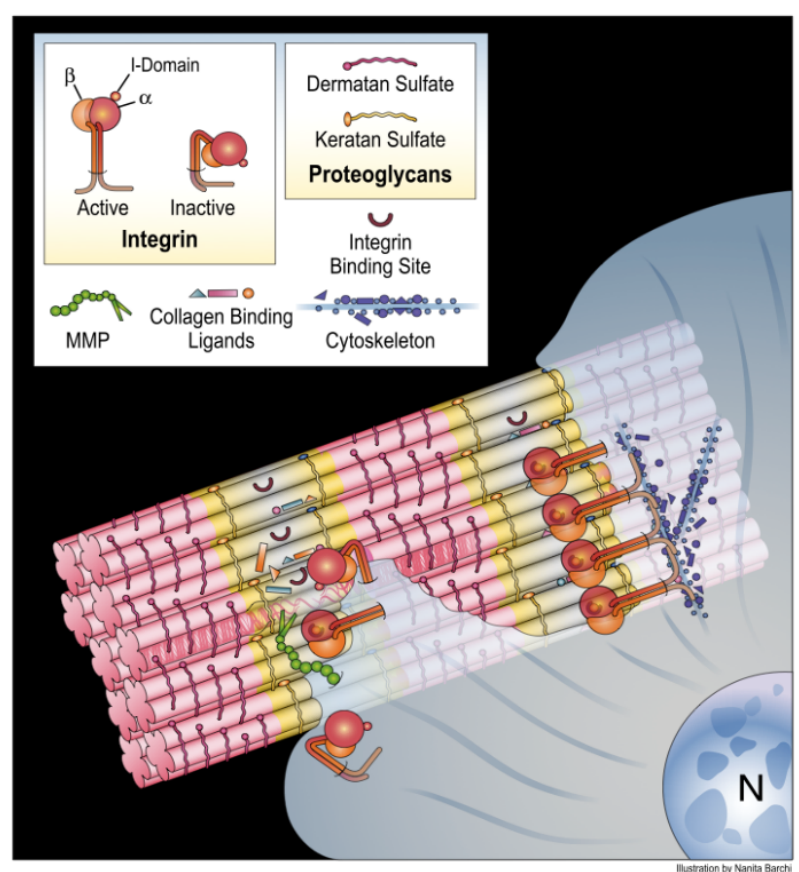
Figure 3. Domain model of collagen fibril function. Type I collagen interactome (Figure 2) and X-ray diffraction fibril model (Figure 4) suggests the conditional domain model of collagen fibril function. Depending on the physiological state of the tissue, the fibril predominantly supports structural duties including intermolecular crosslinking, proteoglycan binding, and biomineralization via the matrix interaction domain; alternatively, dynamic biological processes such as hemostasis, collagen remodeling, and cell adhesion are supported via the cell interaction domain, as schematically shown in Figure 5. This figure was originally published in the J. Biol. Chem. © the American Society for Biochemistry and Molecular Biology